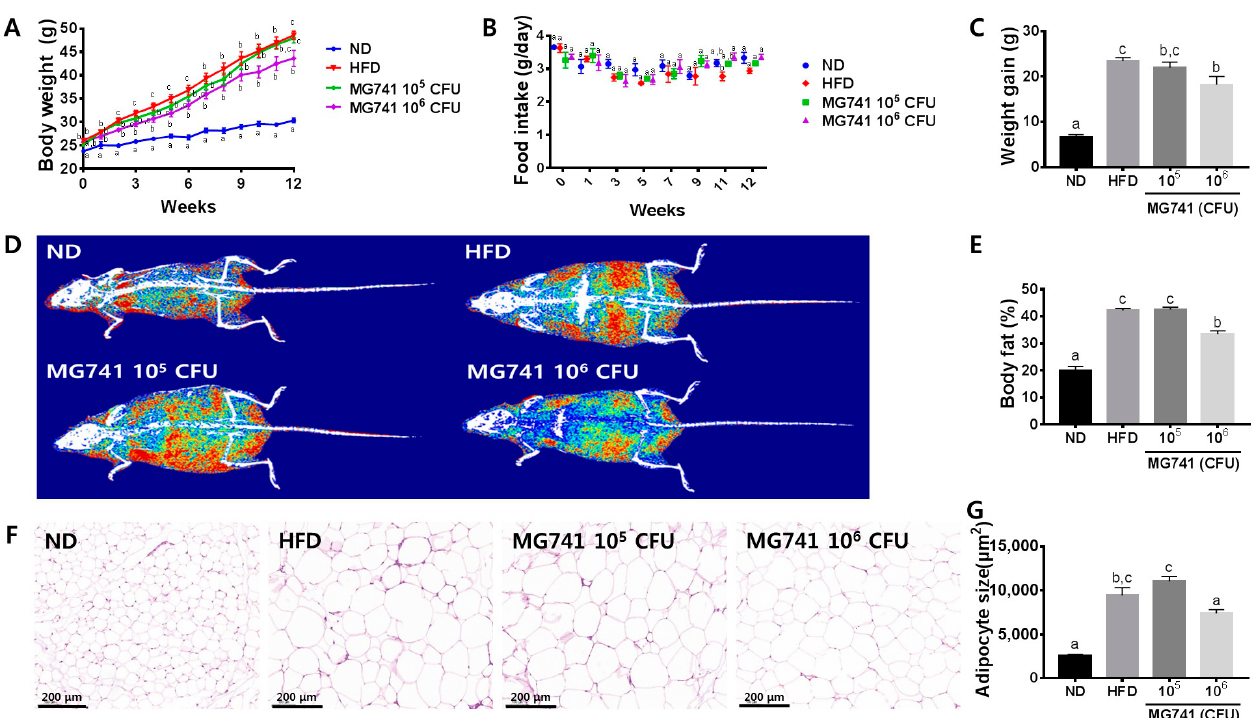
Figure 1. Bifidobacterium animalis ssp. lactis MG741 (MG741) ameliorates high-fat-diet-induced fat deposition. ( A ) Changes in body weight during the experimental period; ( B ) changes in food intake during the experimental period; ( C ) weight gain; ( D ) representative body composition images; ( E ) body fat percent; and ( F ) representative histological results based on H&E staining in white adipose tissue and quantification of adipocyte size. ( G ) Adipocyte size. Data are presented as the mean ± standard error of the mean ( n = 9). The different letters (a–c) indicate significant differences ( p < 0.05) determined by one-way ANOVA with Tukey’s post hoc tests.